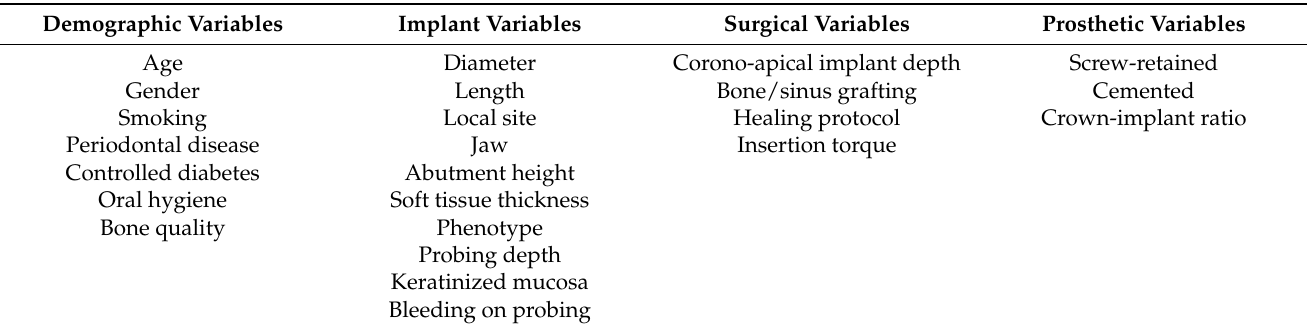
Table 1. Variables recorded in this